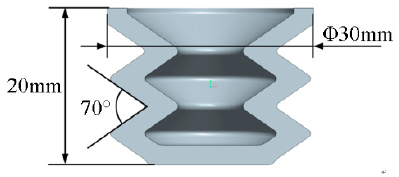
Figure 5. The main structure parameters of the pneumatic bladder.